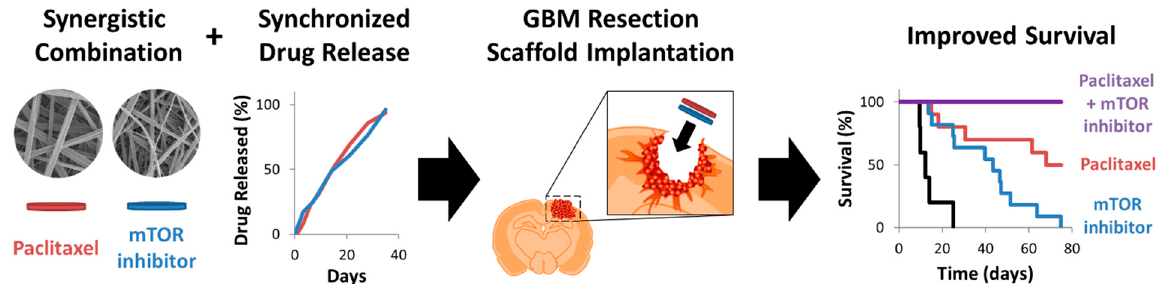
Figure 7. Summary of synergistic interstitial therapy in a resection and recurrence murine GBM model using PTX- and EVR-loaded Ace-DEX fabricated by electrospinning. Combination therapy resulted in 100% survival and prevention of tumor recurrence. Reproduced with permission from [54].